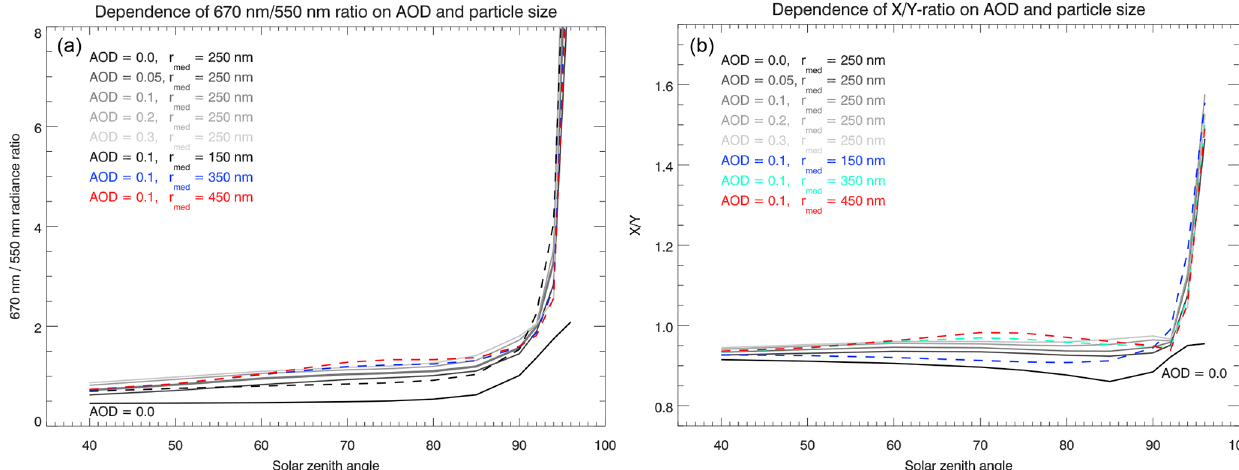
Figure 4. Ratio of the scattered solar radiances at 670 and 550nm (a) and the X/Y tristimulus value ratio (b) as a function of SZA and for different values of the stratospheric AOD and different aerosol size distributions. Note that for SZAs < 90 ◦ the radiance ratio increases monotonously with AOD for the AOD range shown here. Other relevant parameters: VZA = 85 ◦ , SAA = 10 ◦ , TOC = 300DU, A S = 0 . 3, S = 1 .